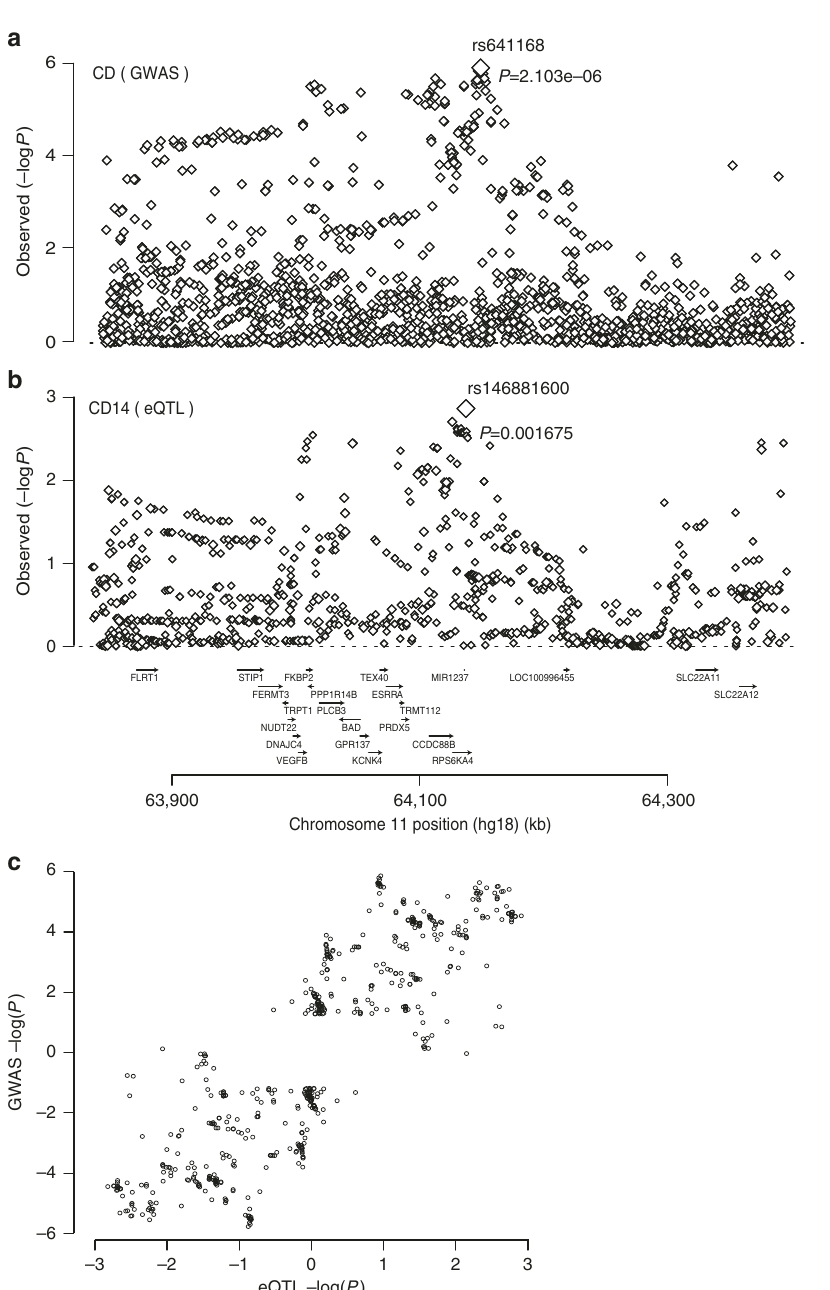
patients (Fig. 5c) (Equation 1, Methods). This analysis identi fi es a signi fi cant correlation (accounting for LD in the region) between eQTLs effects on CCDC88B expression and association (in GWAS dataset) with CD disease risk ( p > 0.01), with increased CCDC88B expression associated with increased risk (Fig. 5c). A similar analysis performed for CD4 + , CD8 + , CD15 + and CD19 +